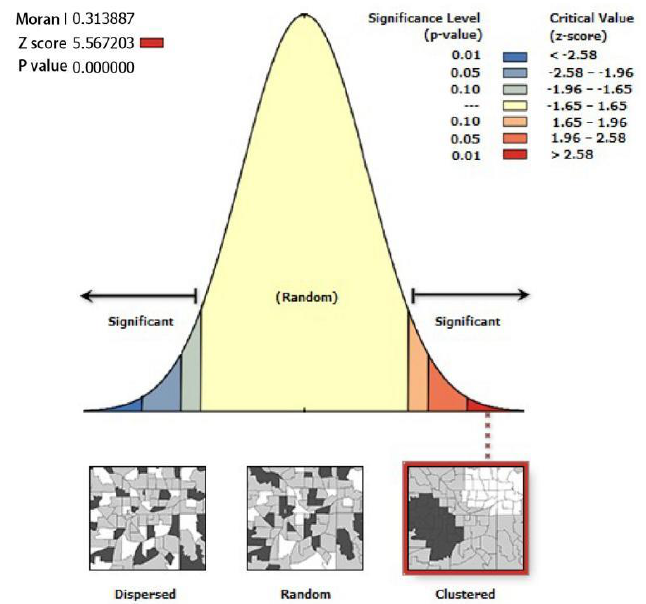
Figure 9. Spatial-clustering effect of green-view value.